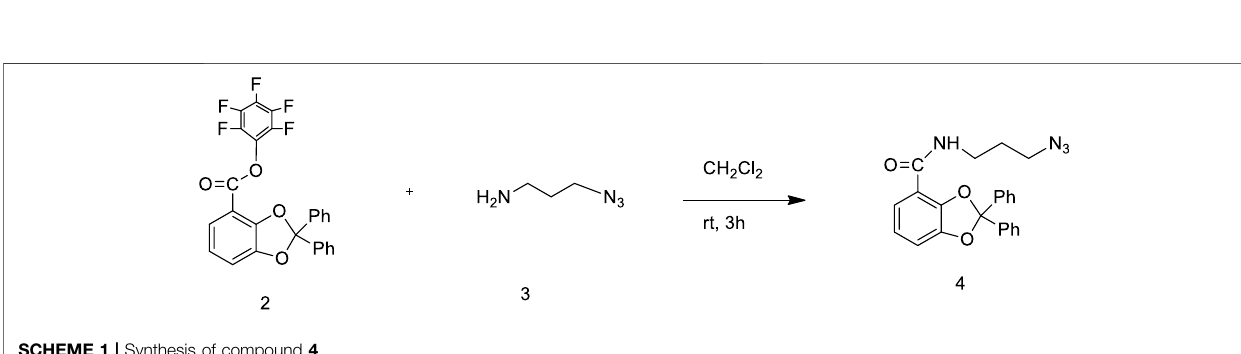
SCHEME 1 | Synthesis of compound 4